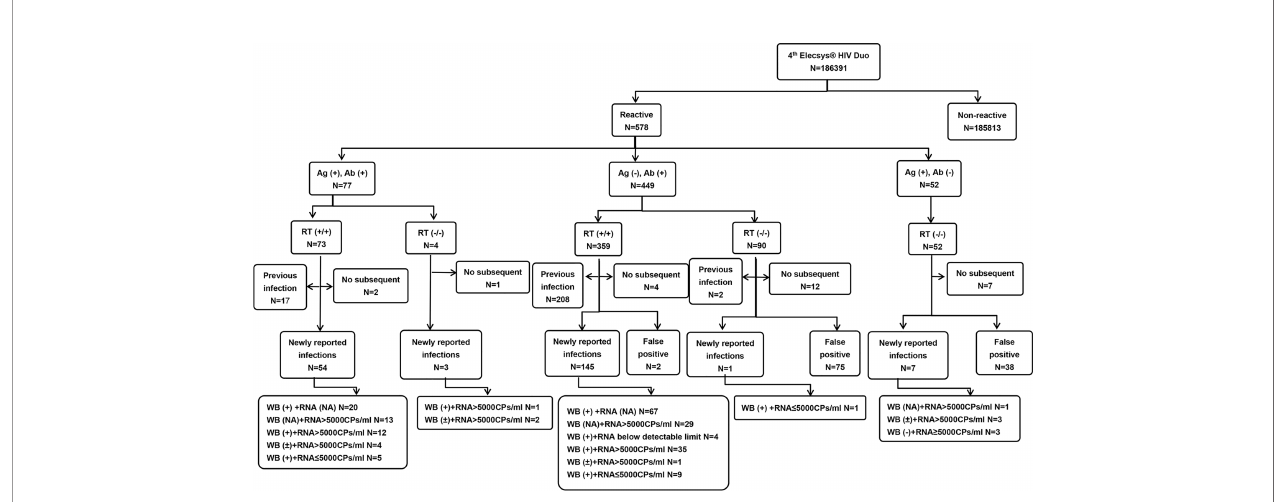
FIGURE 1 | The distributions of the results of the Elecsys ® HIV Duo